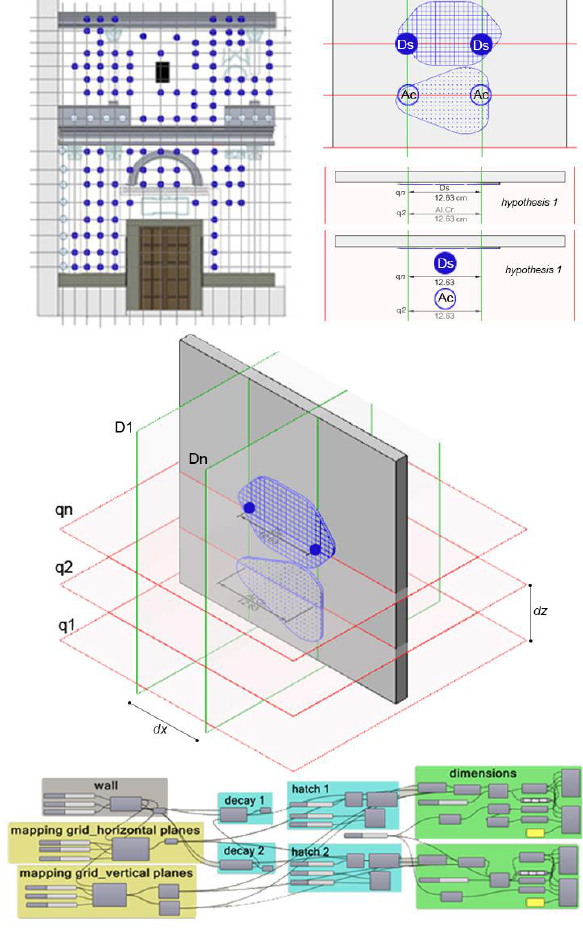
Figure 11 . Semi-automatic - parametric decay representation (VPL): planimetric